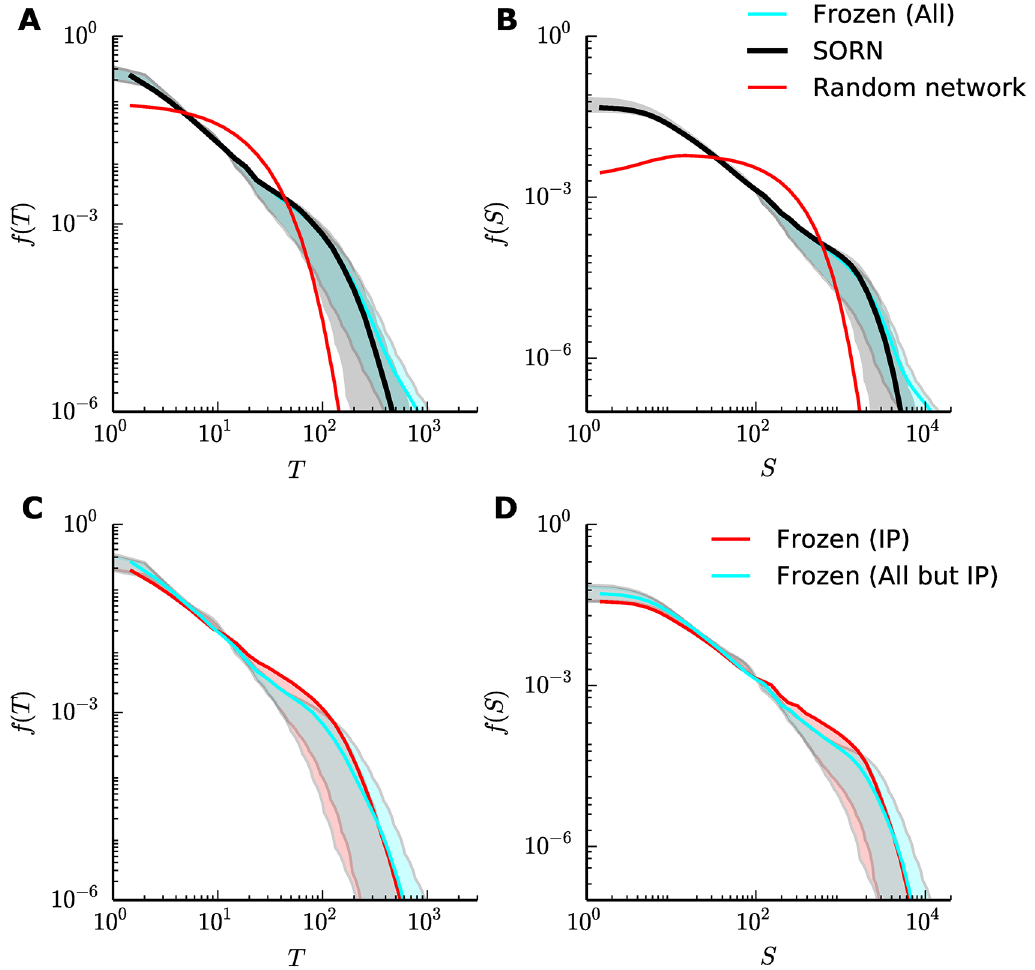
Fig 4. SORN with frozen plasticity. (A), (B) Distributionof avalanchedurationsand sizes, respectively,for N E = 200 units, comparing typical SORNs (black), randomly initializedSORNs without plasticityaction (red) and SORNs with all five plasticity mechanisms frozen at the stable phase(cyan). (C), (D) Distributionof avalanchedurationsand sizes, respectively, for the same network size, comparingSORNs with frozen IP (red) and frozen STDP, iSTDP, SN and SP (cyan) at the stable phase. Curves are combineddata from 50 independentsimulations, and shaded regionsshow the effects of variations in the activity threshold( θ betweenthe 5th and 25th percentilesof the activity